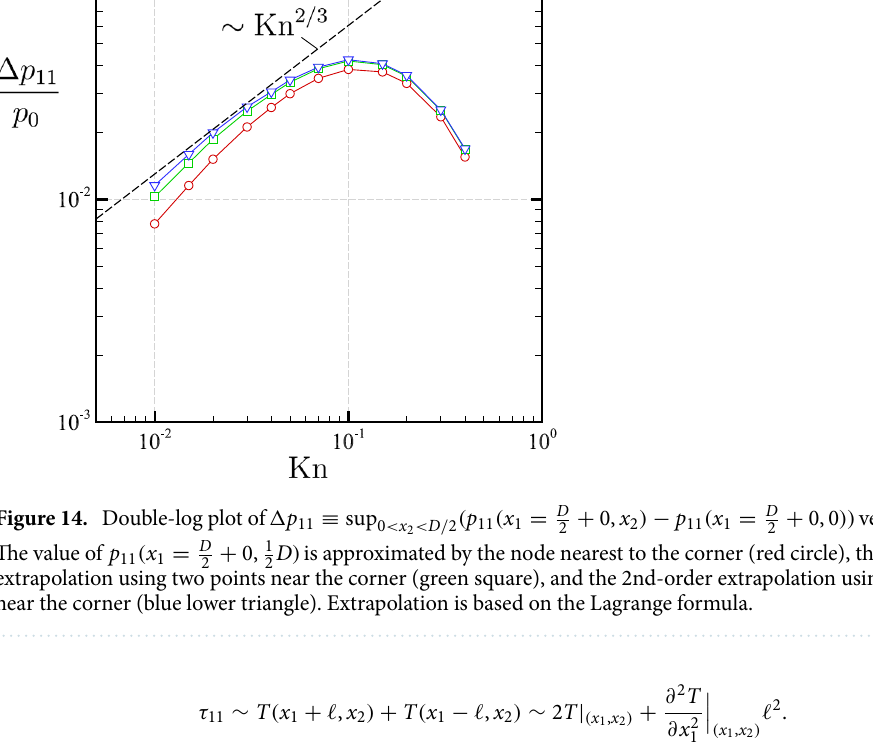
Figure 14. Double-log plot of � p 11 The value of p 11 ( x 1 extrapolation using two points near the corner (green square), and the 2nd-order extrapolation using 3 points near the corner (blue lower triangle). Extrapolation is based on the Lagrange